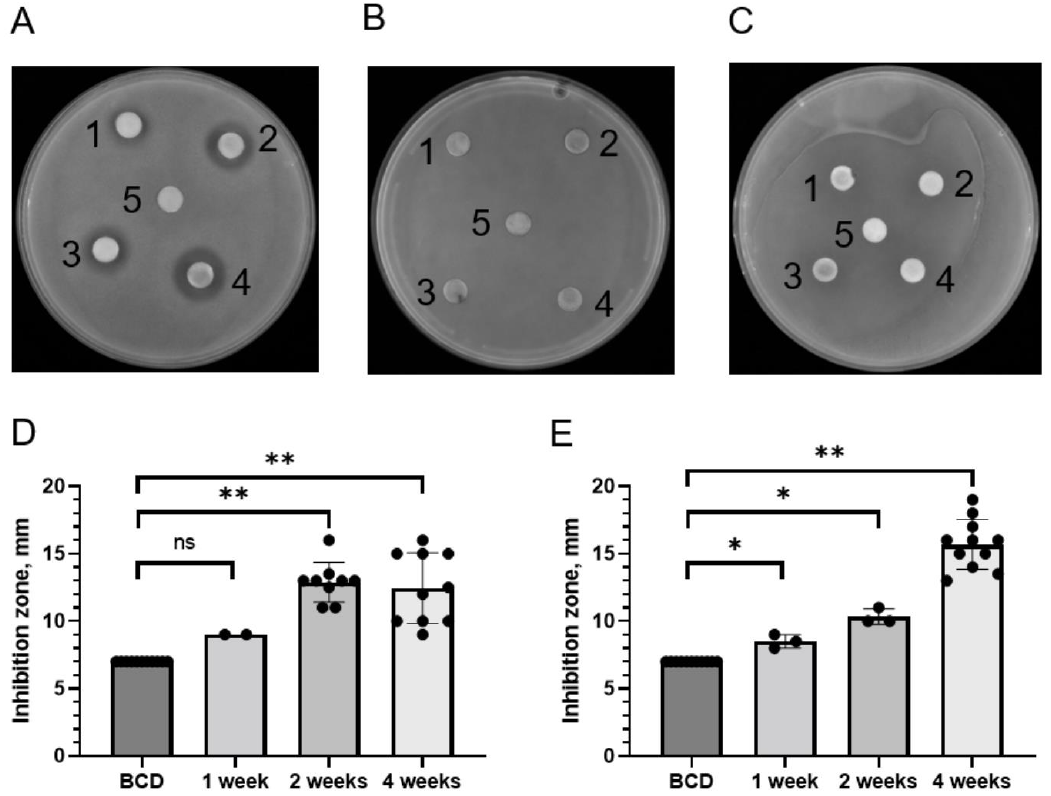
Figure 2. Bacterial growth inhibitory activity of extracellular metabolites from P. patens ecotypes. ( A – C ) Representative pictures of qualitative DDM assays with filter disks soaked with exudates from four-week-old P. patens Gd ecotype and placed on top of S. aureus ATCC25923 ( A ), S. enterica ser. Typhimurium ATCC14028s ( B ) and S. marcescens SM6 ( C ) bacterial lawns. 1–4, disks with P. patens exudates; 5, negative control disks (BCD medium only). ( D , E ) Diameter of S. aureus growth inhibition area (halo) around each cellulose disk containing secreted moss metabolites from one-week, two-week and four-week-old P. patens Gd ( D ) or Vx ( E ) ecotypes was measured and plotted. Data represent the means from at least three independent experiments and a standard deviation. The asterisks indicate significance in an unpaired t -test; *—statistical significance p ≤ 0.05; **—statistical significance p ≤ 0.01; ns—not significant. Table 3. Bacterial growth inhibition activity of exudates from P. patens ecotypes in DDM assays against S. aureus , in mm.